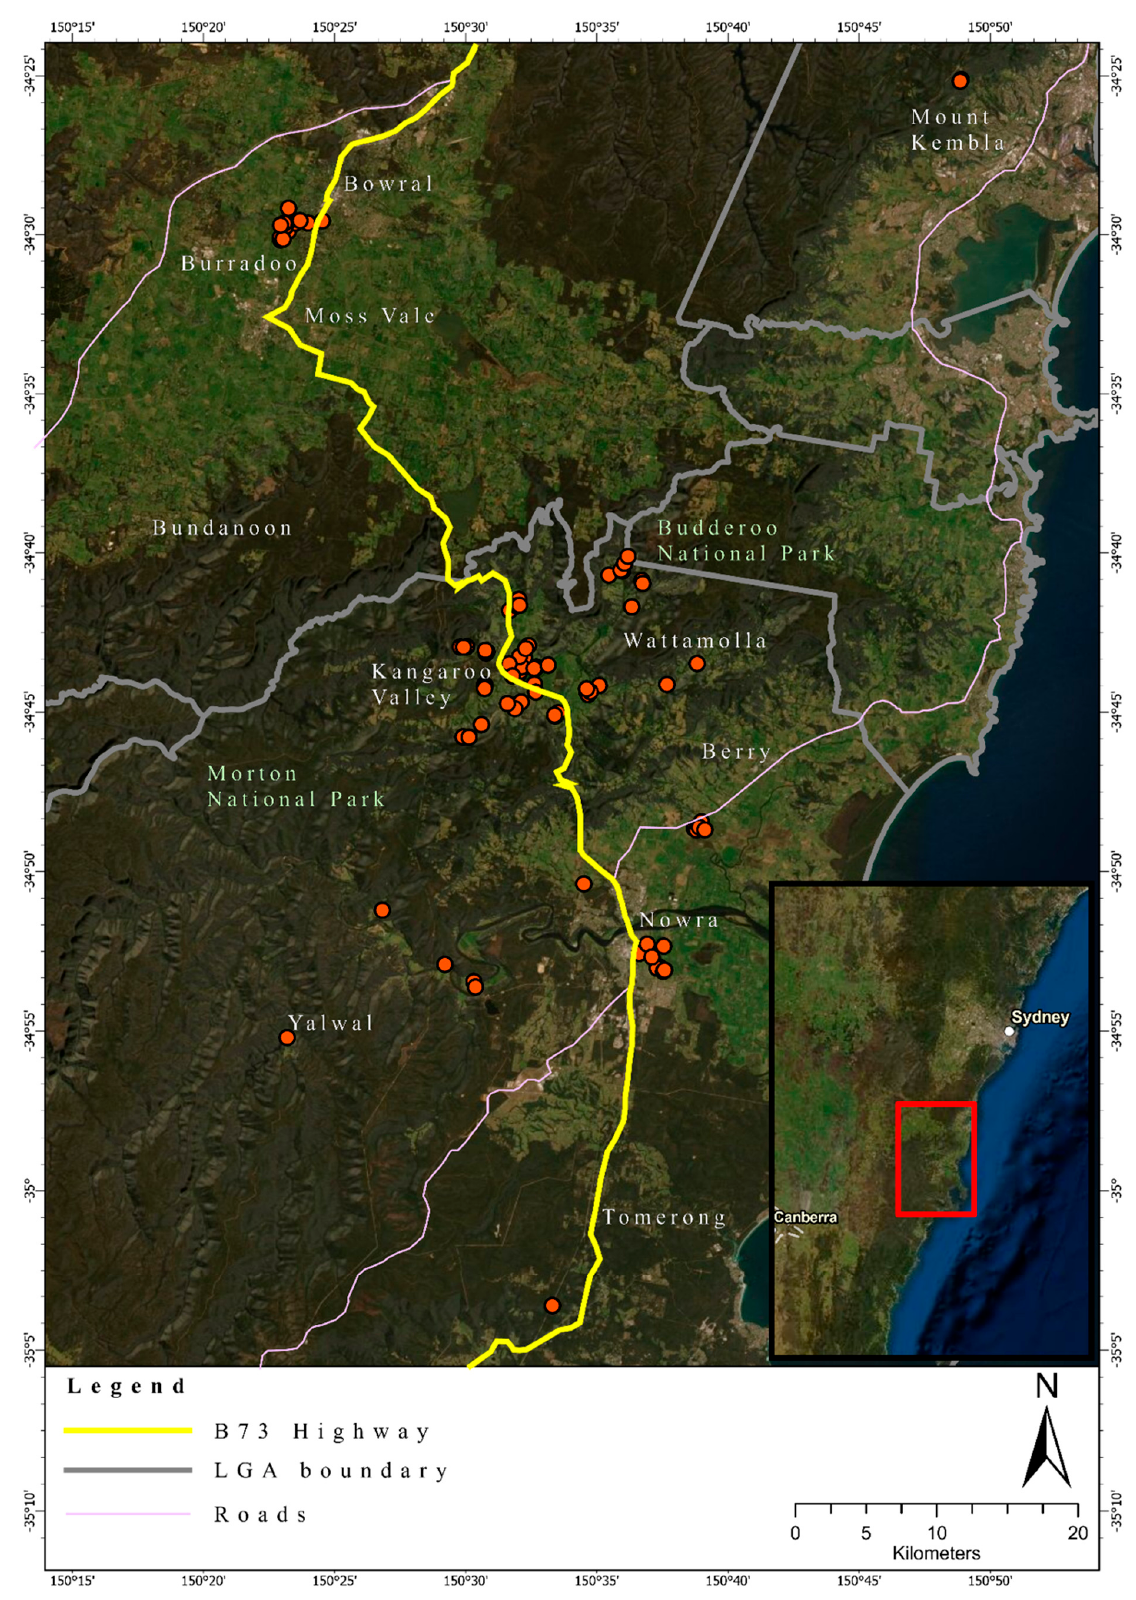
Figure 1. Geographic location of the foxes sampled in this study in south-eastern Australia. Round red dots indicate the location of an individual fox. A total of 94 foxes (Female = 29; Male = 51; Unknown = 14) were sampled across a one-year period. The map was generated using ArcGIS Pro v2.4.